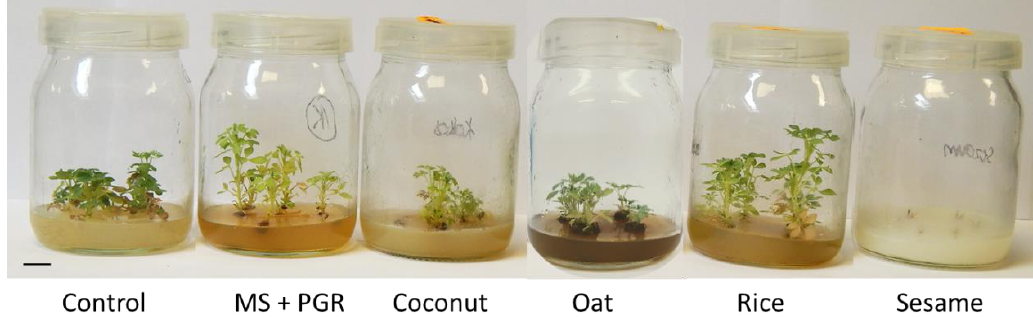
Figure 3. Influence of medium composition on the development of shoots in L. spectabilis ‘White Gold’ after 10 weeks of culture; bar = 1 cm.